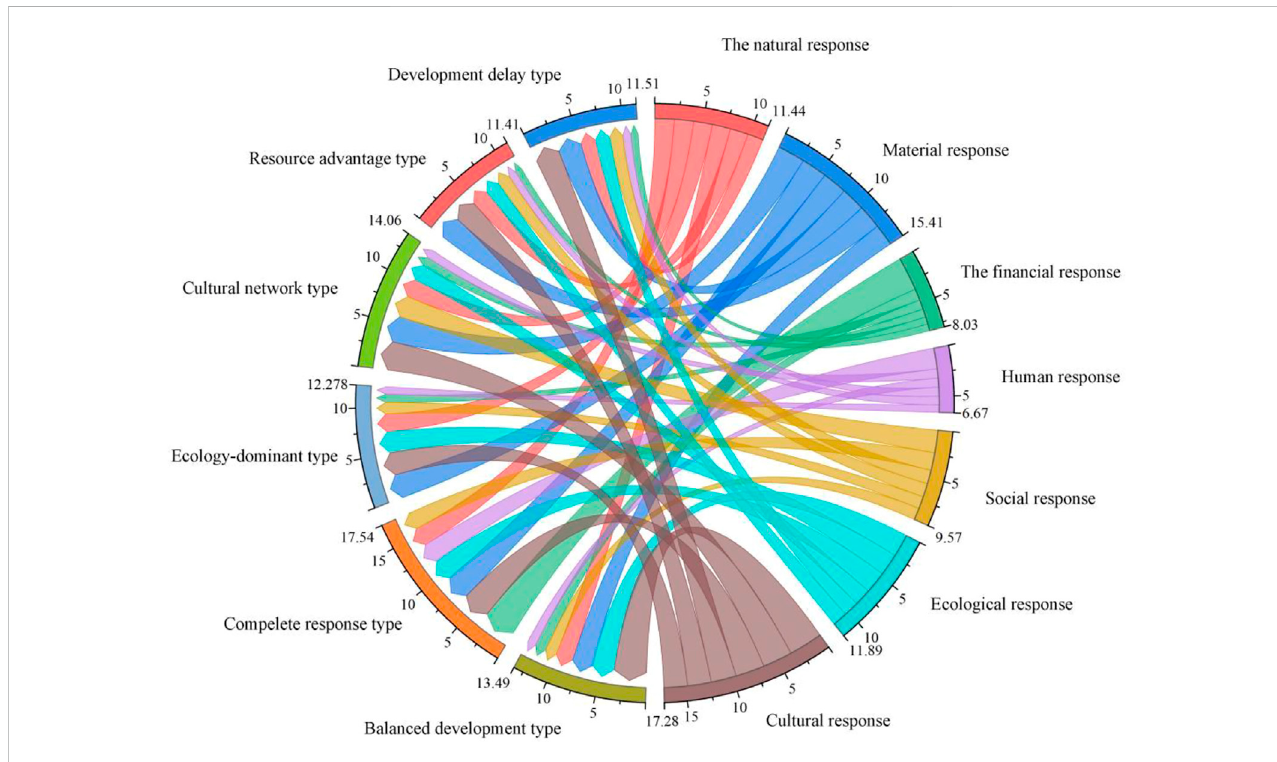
FIGURE 4 Degree of response of different response type